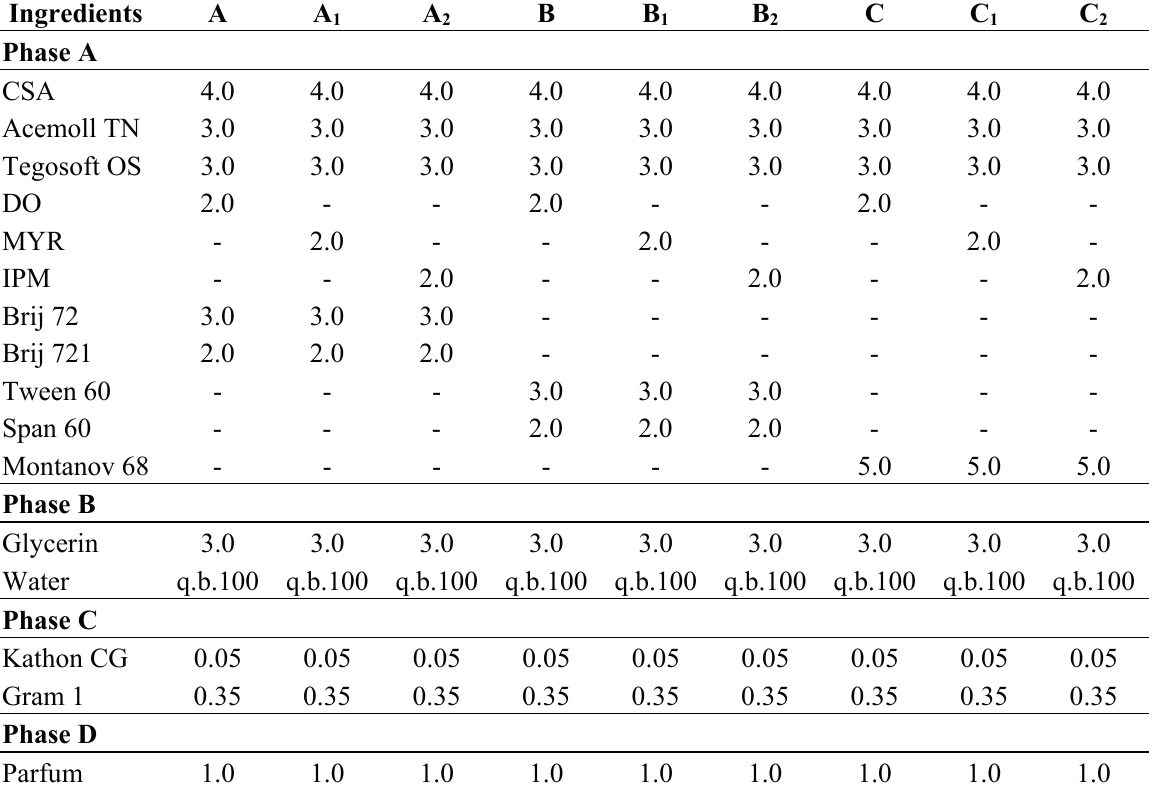
Table 1. Composition (% w / w ) of cosmetic O/W emulsions containing tocopherol acetate (1% w / w ).